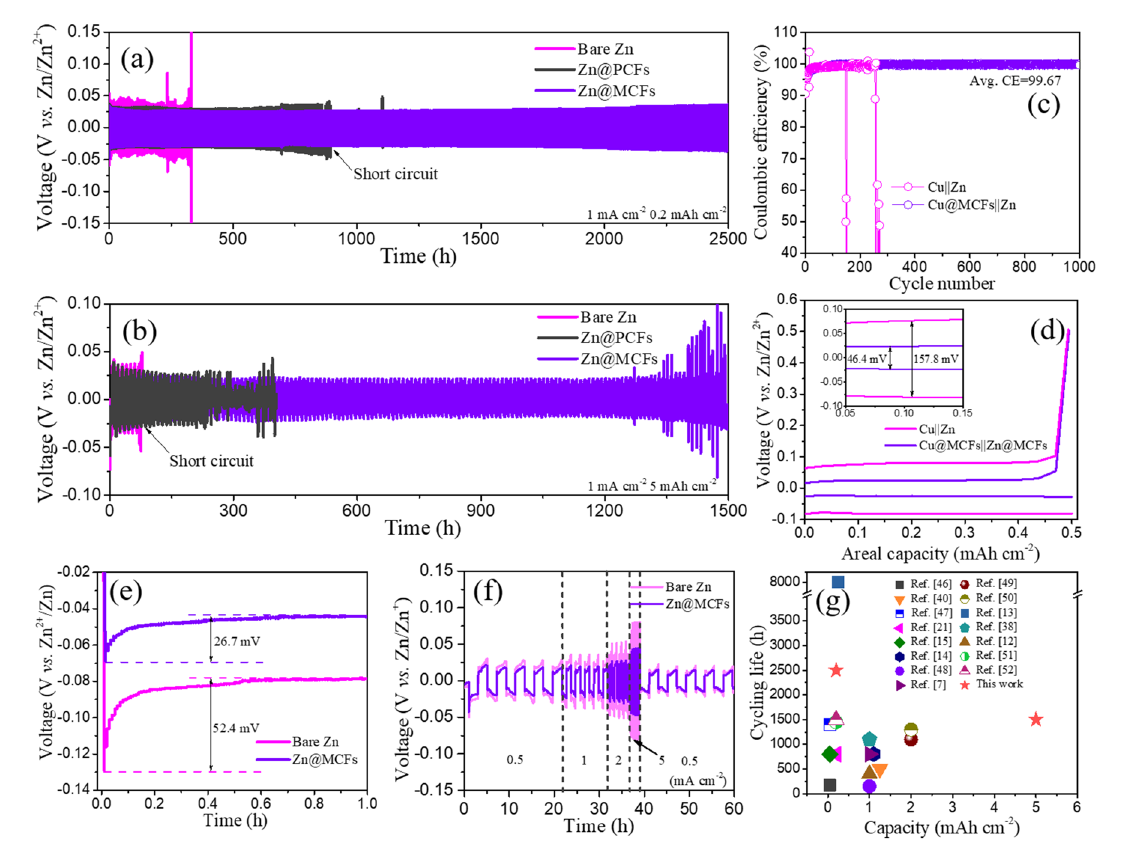
Fig. 3 Galvanostatic plating/stripping test of bare Zn, Zn@PCFs and Zn@MCFs in symmetric cells with a capacity of a 0.2 mAh cm −2 at 1 mA cm −2 , b 5 mAh cm −2 at 1 mA cm −2 . c Coulombic efficiency of Zn plating/stripping in Cu||Zn asymmetrical cells with/without protection of MCFs. d Voltage–capacity curves of Cu||Zn and Cu@MCFs||Zn@MCFs asymmetrical cells at 50th cycle. e Voltage–time curves of Zn plat‑ ing on bare Zn and Zn@MCFs at 5 mA cm −2 . f Rate performance of bare Zn and Zn@MCFs symmetric cells. g Comparison of plating/stripping performance of Zn@MCFs anode with some previously reported anodes modified by various interfacial